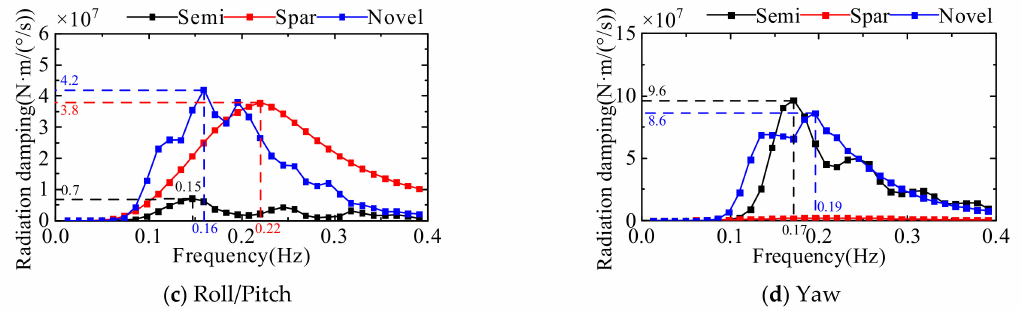
Figure 19. Comparison of the radiation damping of three floating platforms.